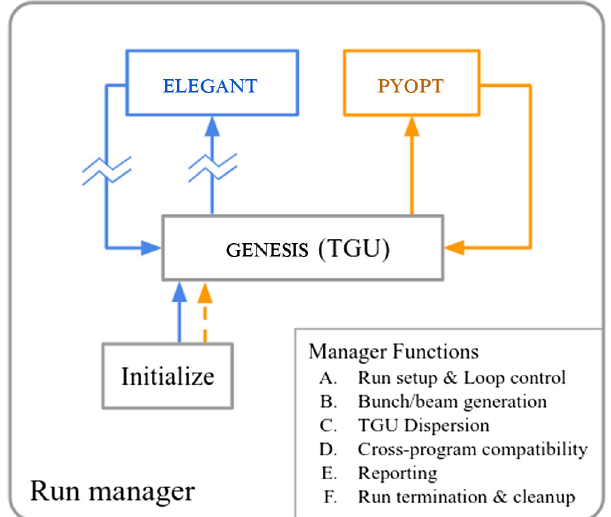
FIG. 7. Flowchart of simulation pipeline used in the study. Blue lines indicate the electron simulation pathway, while orange lines indicate the x-ray pathway. The dashed line indicates an optional step. The run manager serves as a wrapper program that provides functions for initialization, beam generation/manipulation, re- text for details of modification), while ELEGANT handles